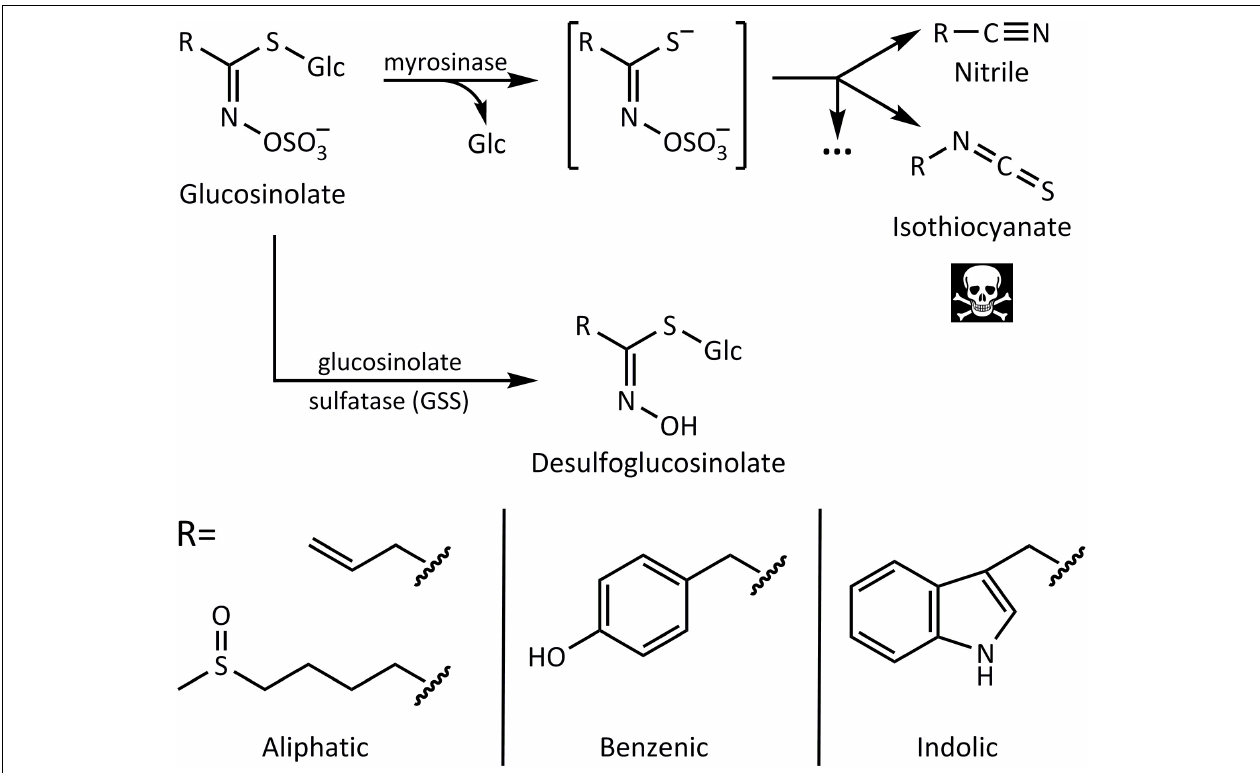
FIGURE 1 | Glucosinolate activation by myrosinase leads to nitriles and toxic isothiocyanates, whereas desulfation by glucosinolate sulfatase (GSS) forms desulfoglucosinolates that cannot be activated. Below are examples of side chains of aliphatic, benzenic, and indolic glucosinolates derived from different amino acid